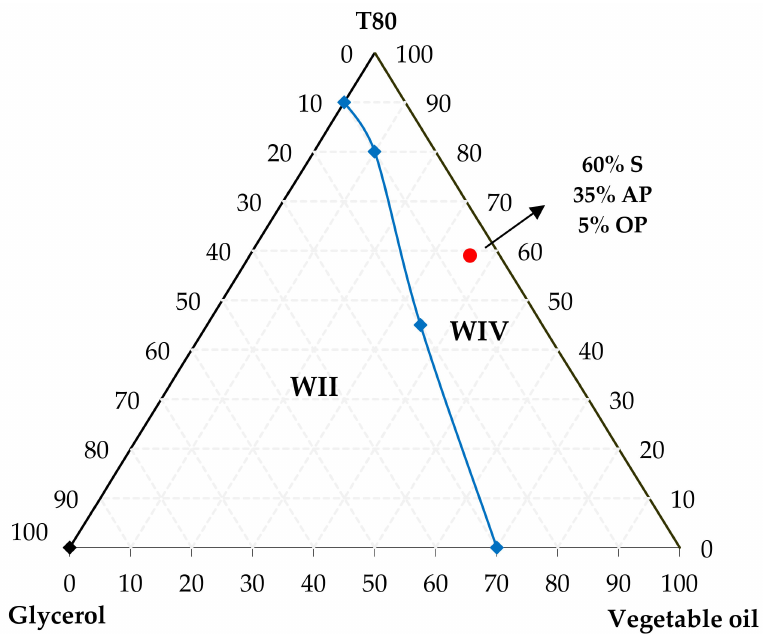
Figure 1. Ternary phase diagram for system 1 (vegetable oil / T80 /